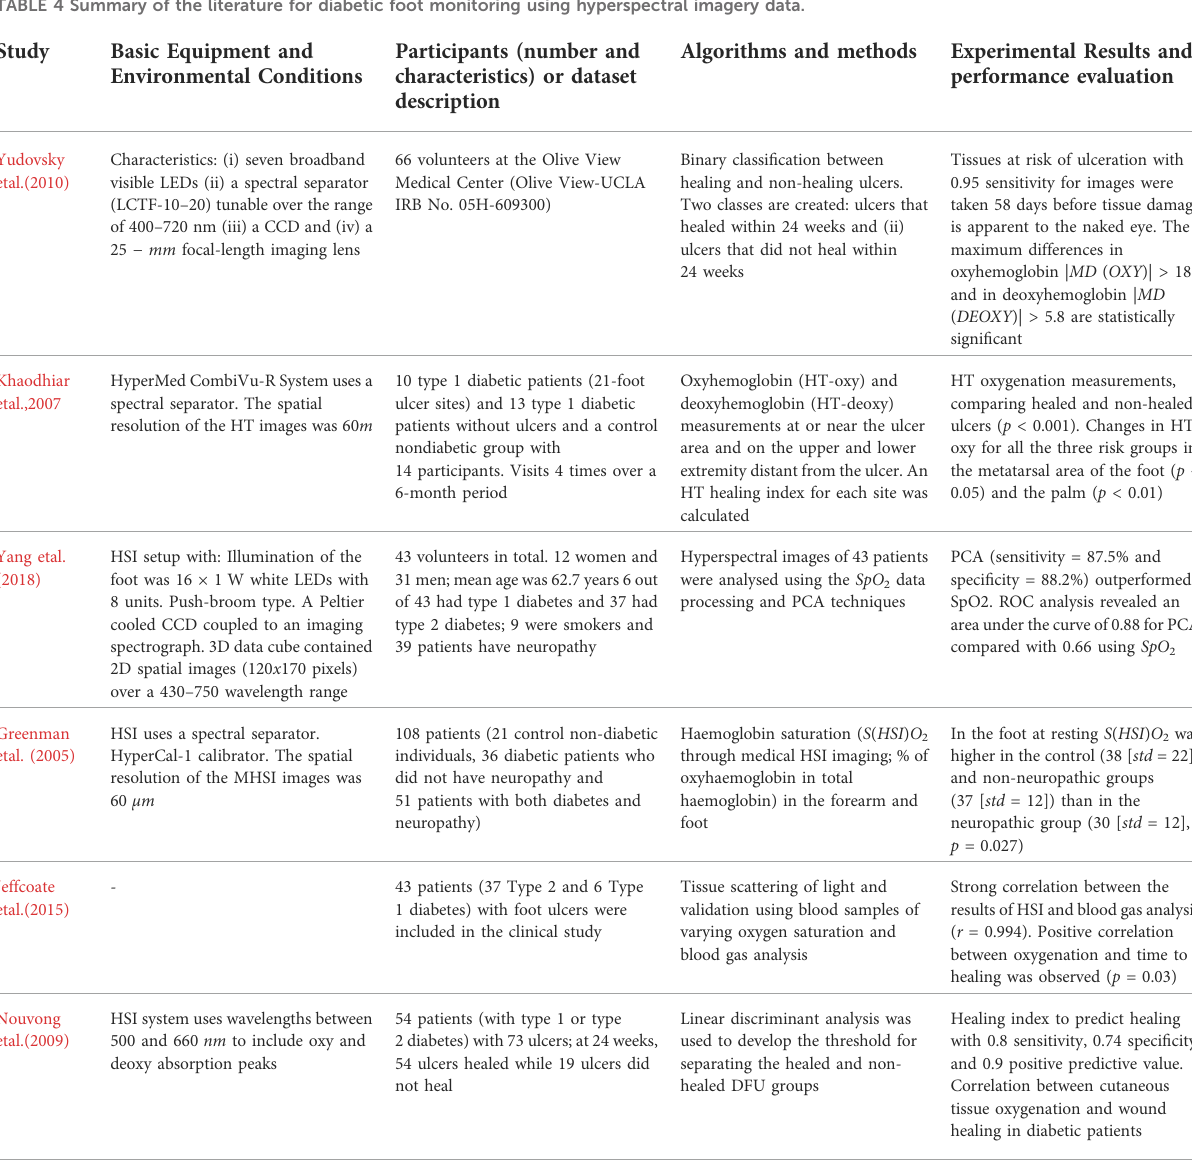
TABLE 4 Summary of the literature for diabetic foot monitoring using hyperspectral imagery data.